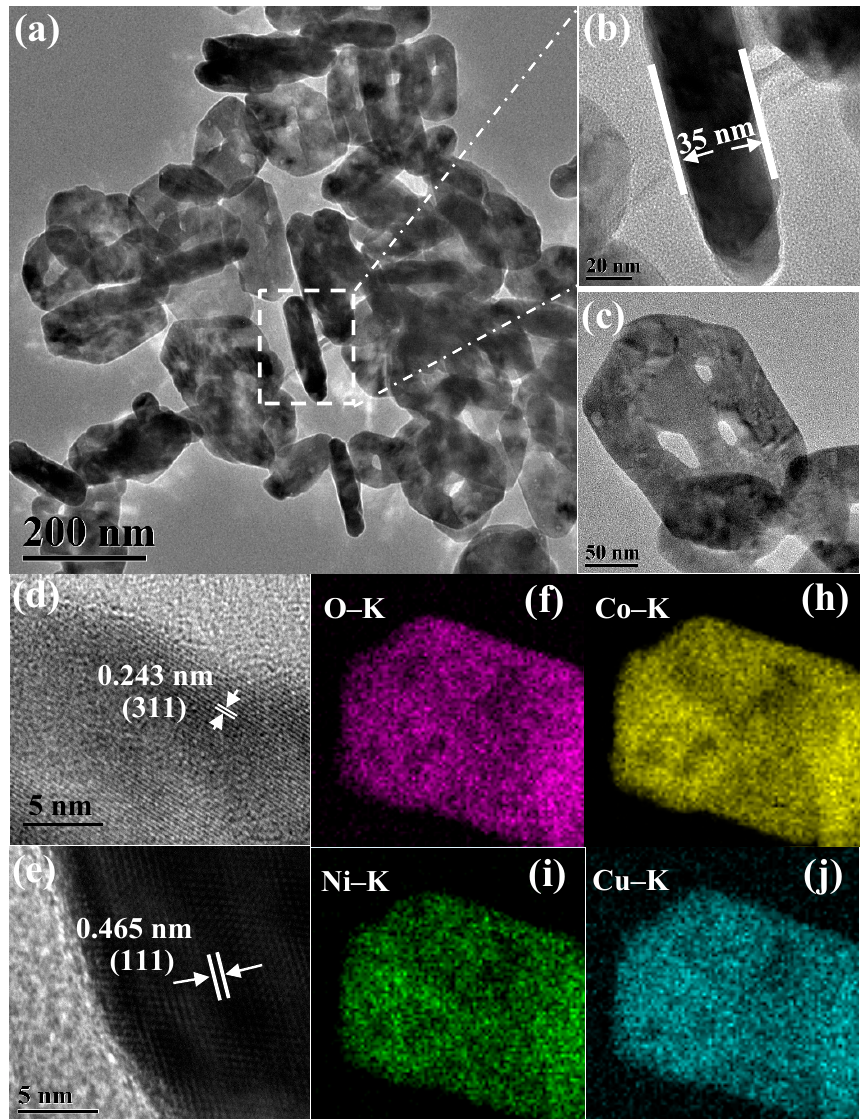
Figure 3. TEM images of Ni 0.5 Cu 0.5 Co 2 O 4 nanoplatelets ( a – c ), HRTEM images of Ni 0.5 Cu 0.5 Co 2 O 4 nanoplatelets ( d , e ), and the elemental mapping of a piece of Ni 0.5 Cu 0.5 Co 2 O 4 nanoplatelet ( f , h – j ). FT-IR spectroscopy analysis was performed on Ni 0.5 Cu 0.5 Co 2 O 4 nanocomposites to determine the